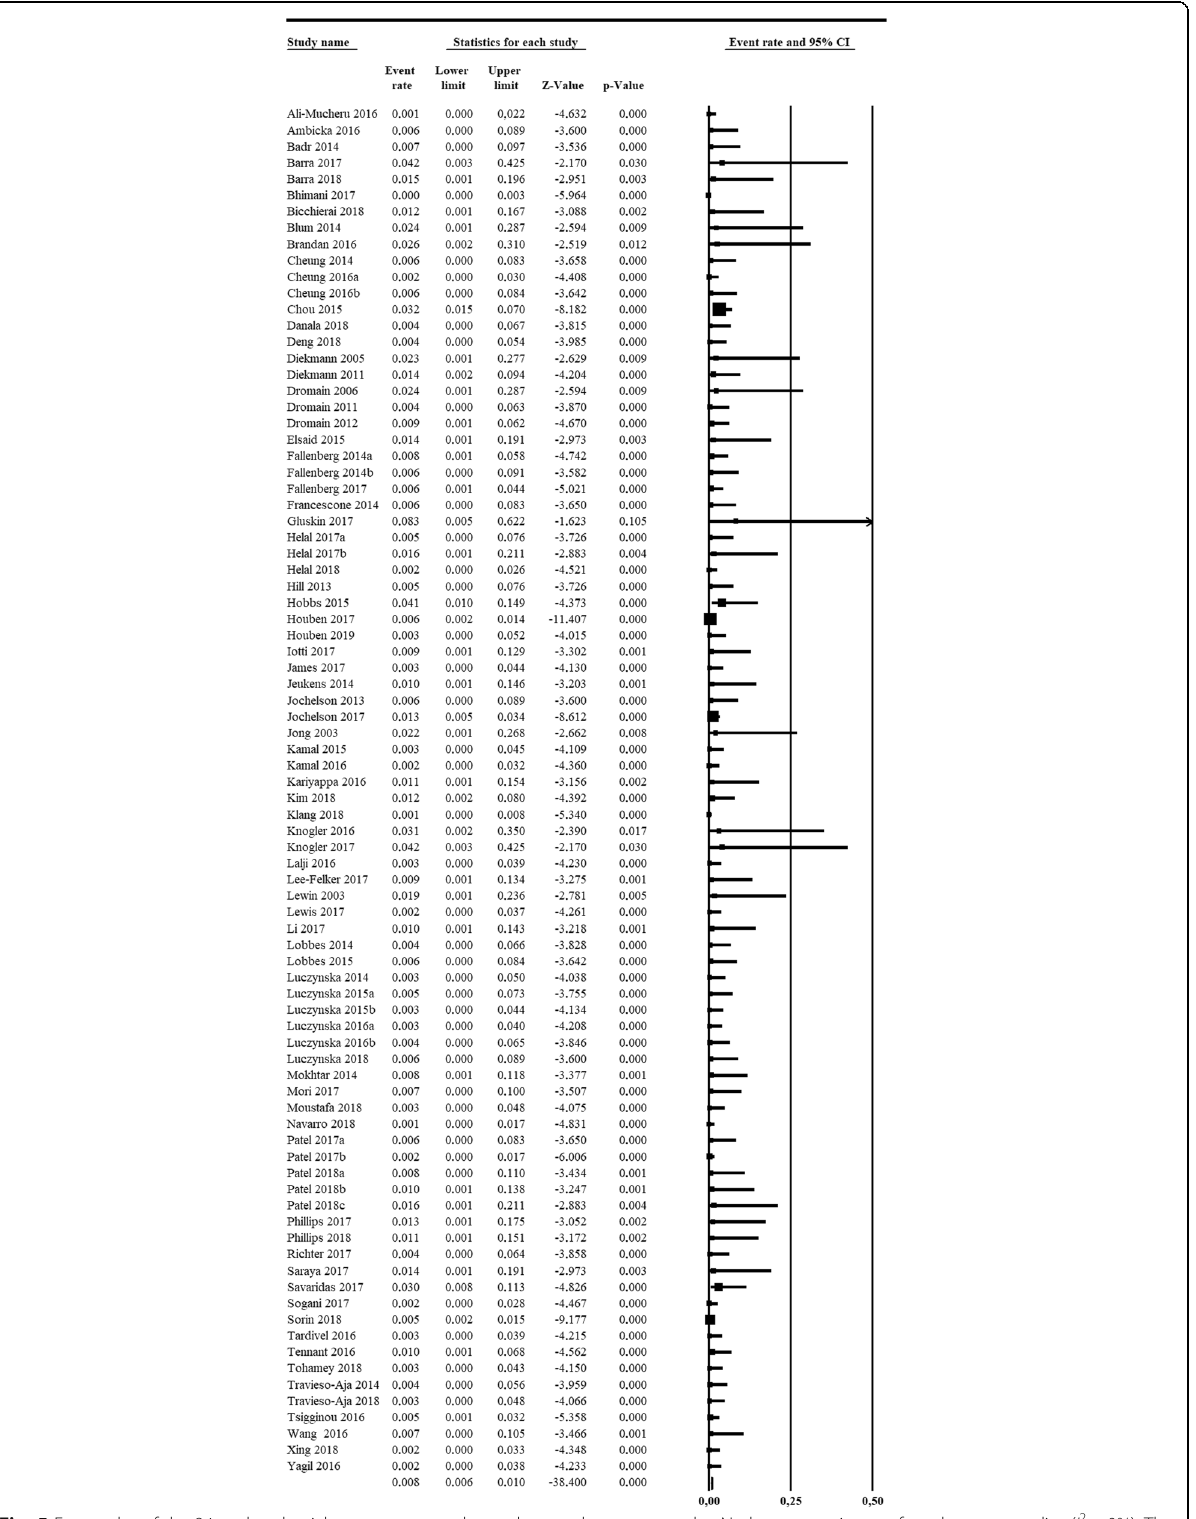
Fig. 5 Forest plot of the 84 analysed articles on contrast-enhanced spectral mammography. No heterogeneity was found among studies ( I 2 =0%). The last row shows the pooled rate for adverse reactions arising from iodinated contrast agent administration, calculated using the fixed-effect